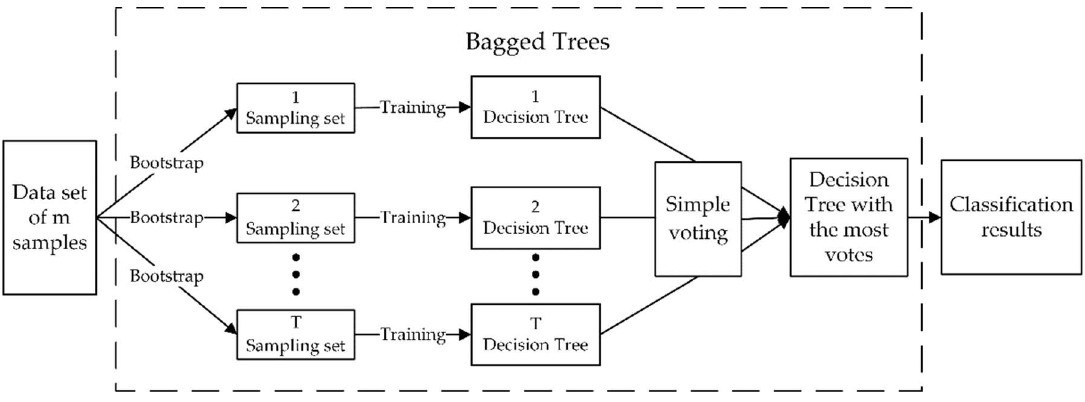
Figure 7. The flow chart of Bagged Trees.